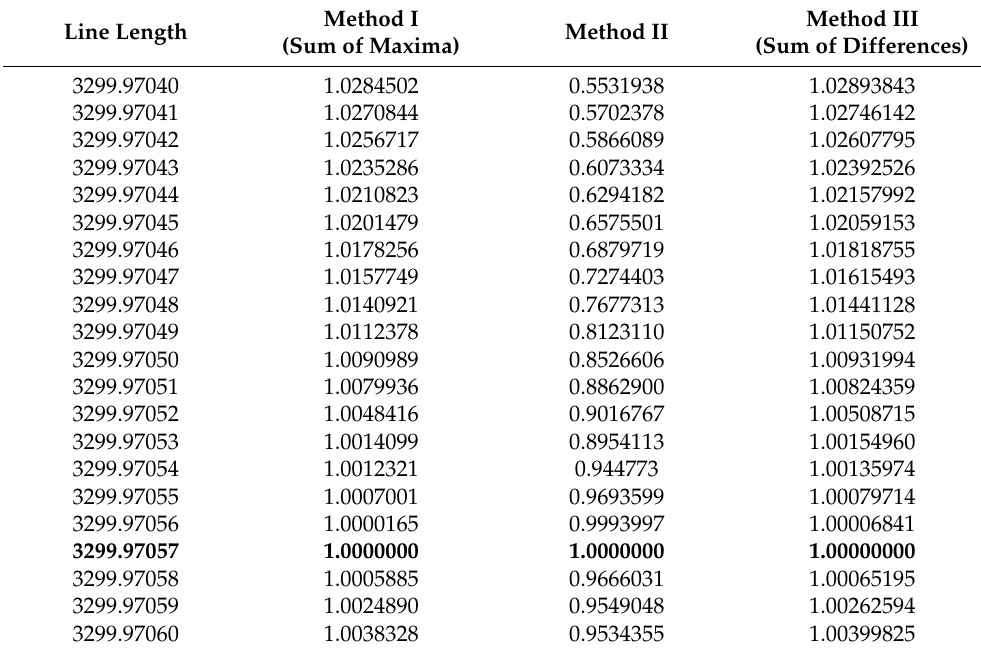
Table 17. Image line length estimation results for the accuracy ∆ = 0.00001.